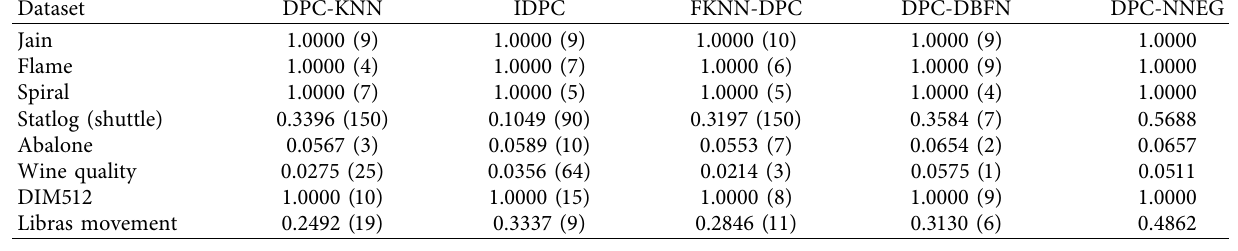
Table 5: Clustering results measured by ARI.